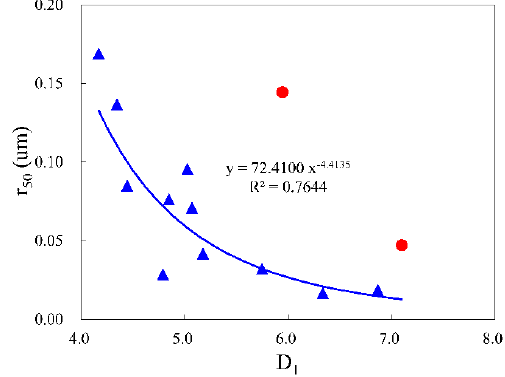
Figure 4. Plot of the sum of fractal dimension D 1 versus r 50 . Table 2. Parameters of the fractal dimension obtained from the 13 samples.